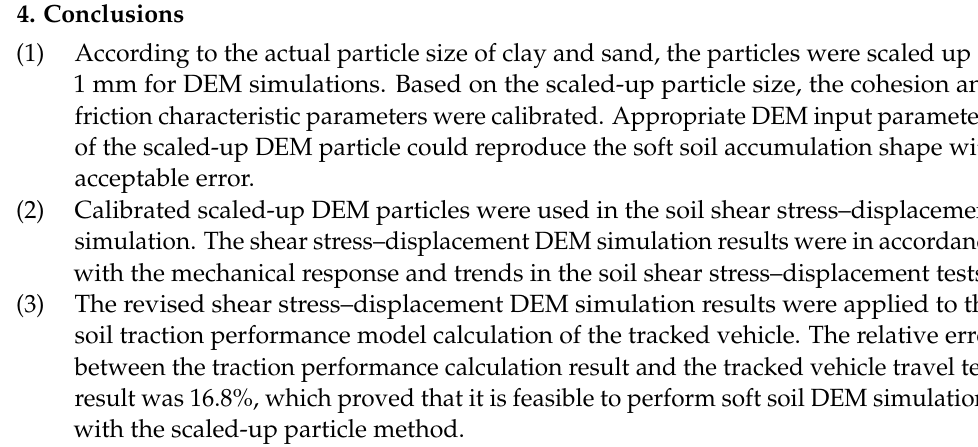
Figure 23. External load derived by the motor current.